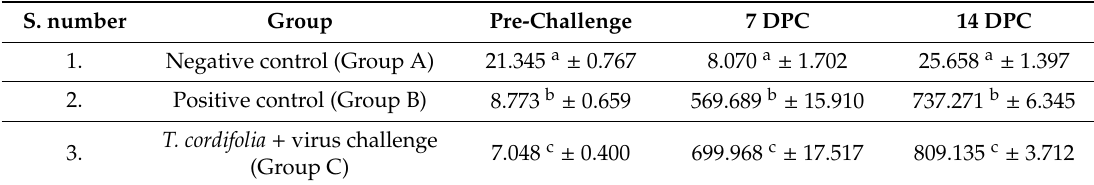
Table 11. Serum antibody titer (mean ± SE of antilog of Log 10 titer) in chickens challenged with vvIBDV at di ff erent DPC by ELISA kit